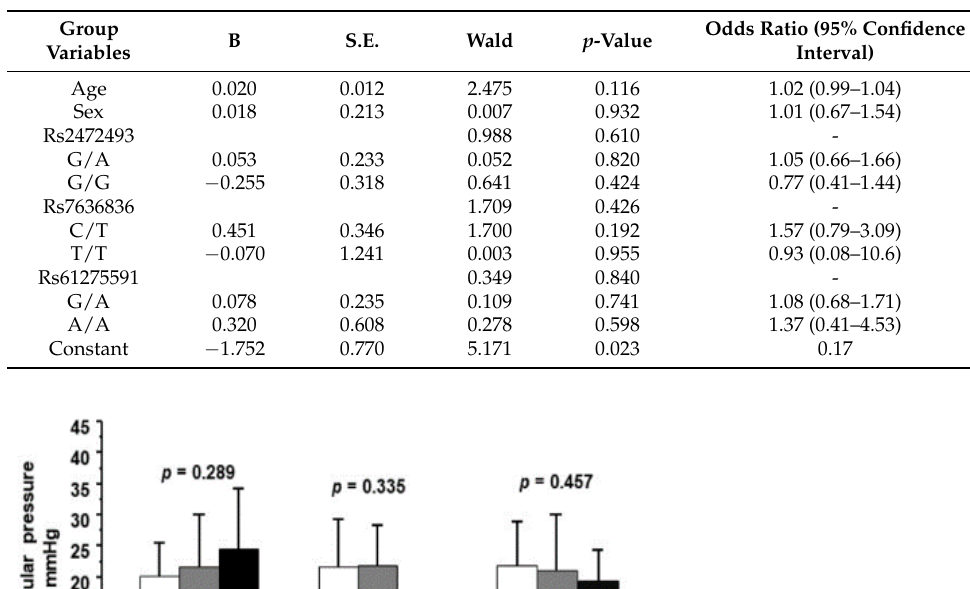
Table 6. Binary logistic regression analysis to determine the effect of age, sex, rs2472493, rs7636836, and rs61275591 genotypes on the risk of disease outcome.